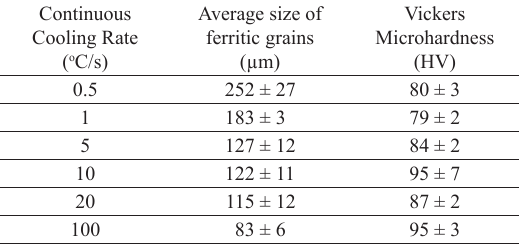
Table 2. Average ferritic grain sizes and average Vickers microhardness values as a cooling rate